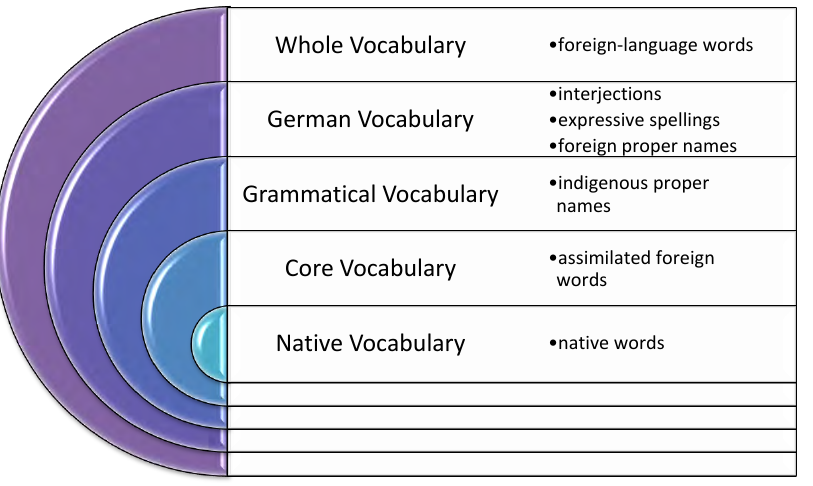
Figure 3: Levels of the vocabulary of German The ‘Whole Vocabulary’ consists of foreign-language words plus the German Vocabulary.